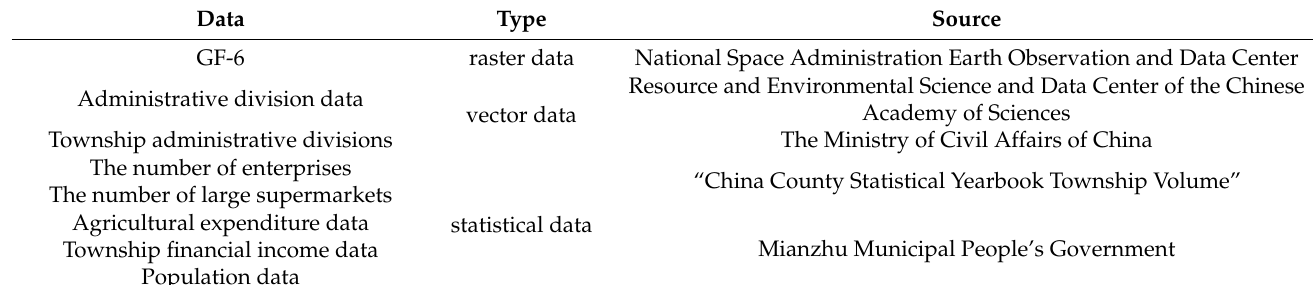
Table 1. Data sources.